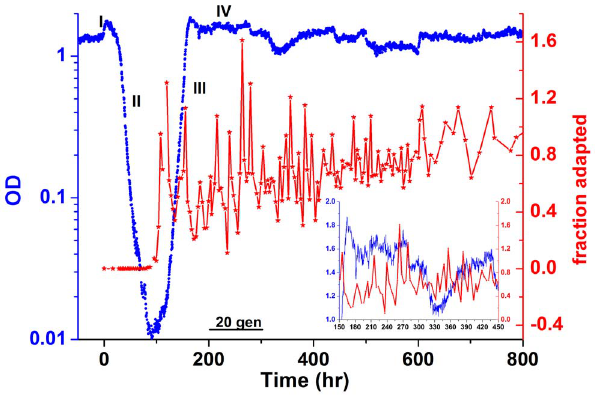
Figure 1. Chemostat population dynamics. The blue trace shows the typical population density (measured by the OD at 600 nm) as a function of time for our rewired cells grown in a chemostat, upon switch from galactose medium to glucose medium lacking histidine (glu-his) at t=0. Note the logarithmic scale. The four phases of the dynamics are marked I-IV. The red trace shows the number of cells that are able to grow a visible colony within 3 days after plating on glu-his agar plates (‘‘fraction adapted’’) relative to the number of colonies grown on rich medium plates (and thus can be larger than 1). Inset: a subset of the blue and red curves, focusing on the time between 150– 450 hrs after switch to glucose. Bar: 20 chemostat generations.